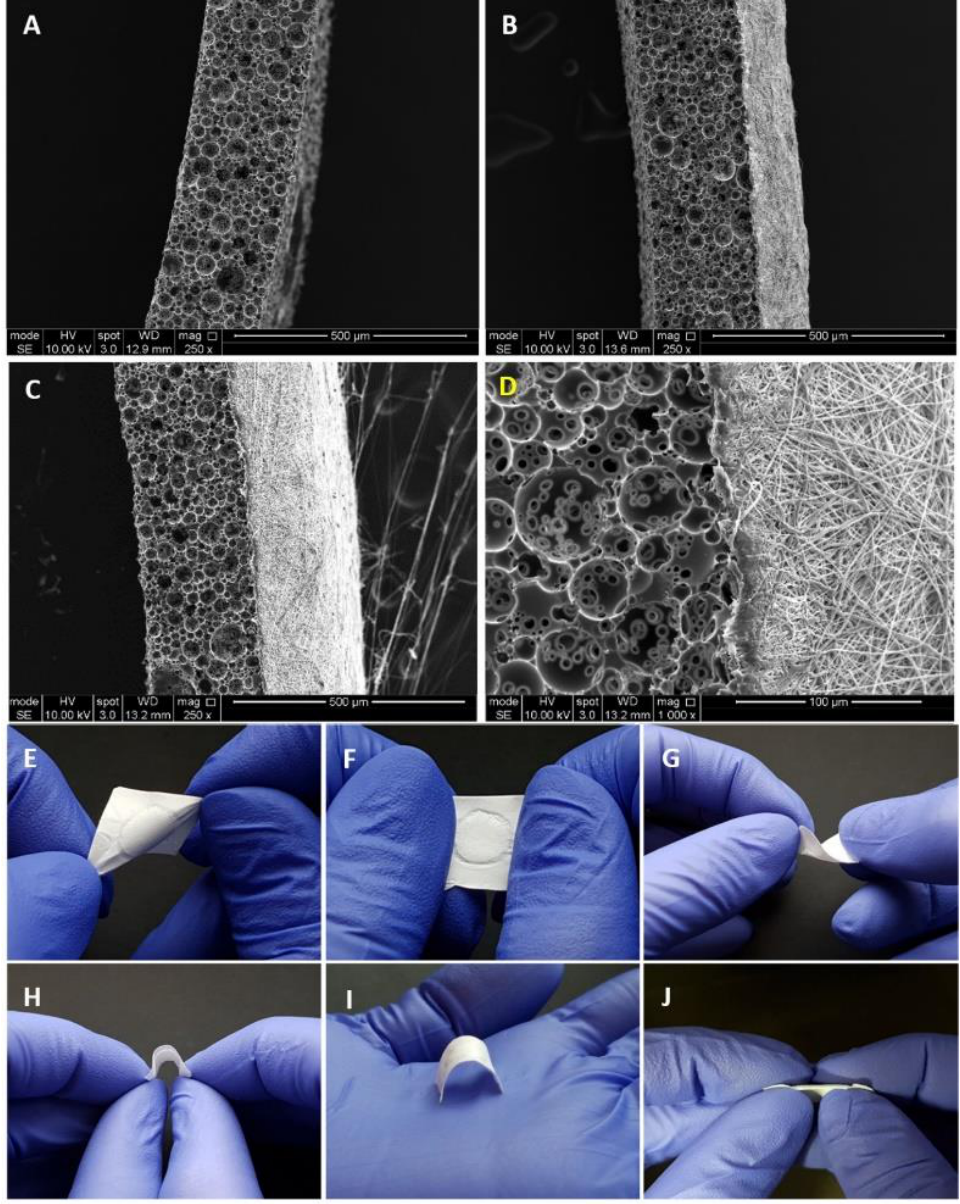
Figure 7. SEM images of ( A ) 250 µ m sectioned PCL polyHIPE layer, ( B ) 20 min PCL electrospun on PCL polyHIPE, ( C ) 40 min PCL electrospun on PCL polyHIPE, ( D ) Higher magnification SEM image showing the border of two layers. Macro images of the bilayer PCL barrier membrane (BM) to